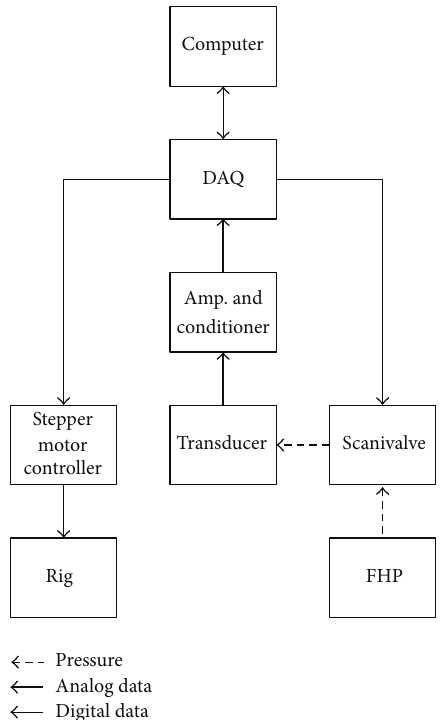
Figure 2: Calibration block diagram for Five-Hole Probe measure-